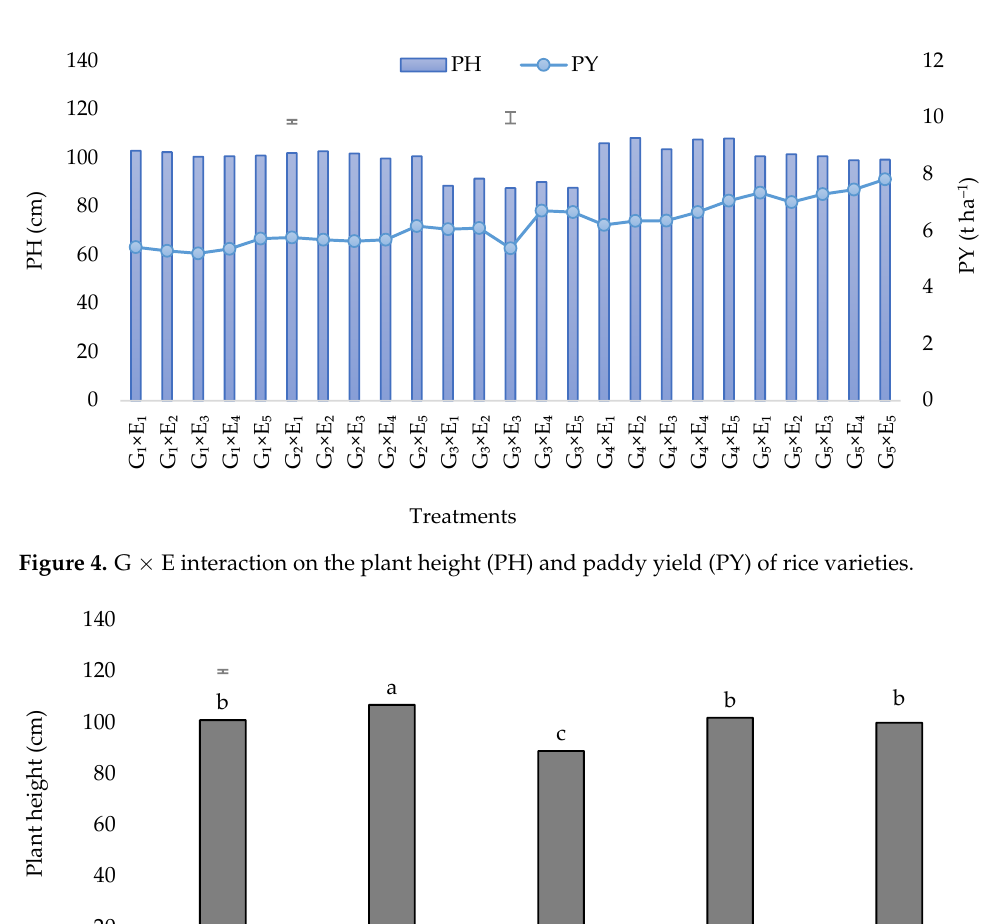
6 Table 3. Effect of location (environment) on the yield attributes and yield of rice varieties. Locations